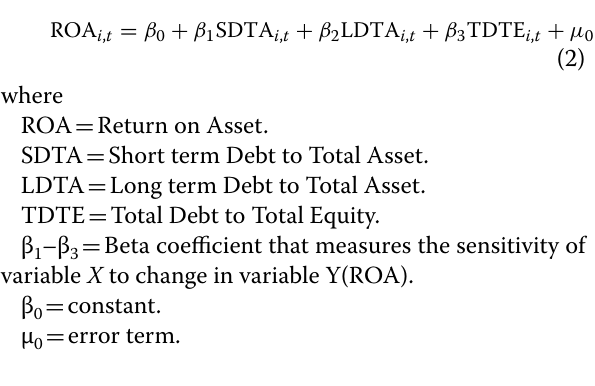
Table 1 Showing the unit root test